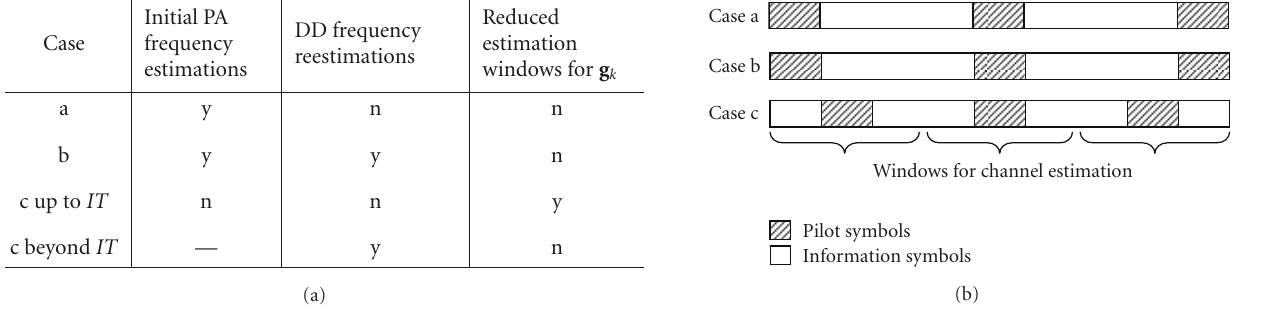
Figure 8: Approach with frequency estimations: (a) operations performed, (b) distributions of pilot